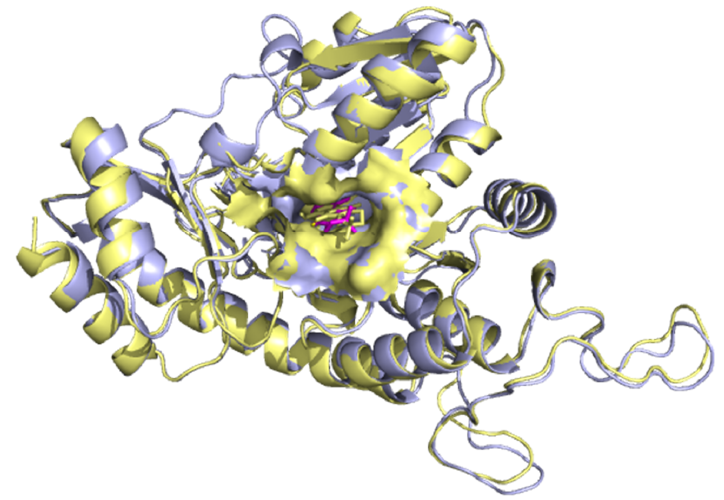
Figure 1. Superimposition of 3qhx (pale yellow) on 4l0O (aquamarine). The RMSD for the structural alignment was 0.66 Å, which is indicative of the high similarity between the two protein structures.